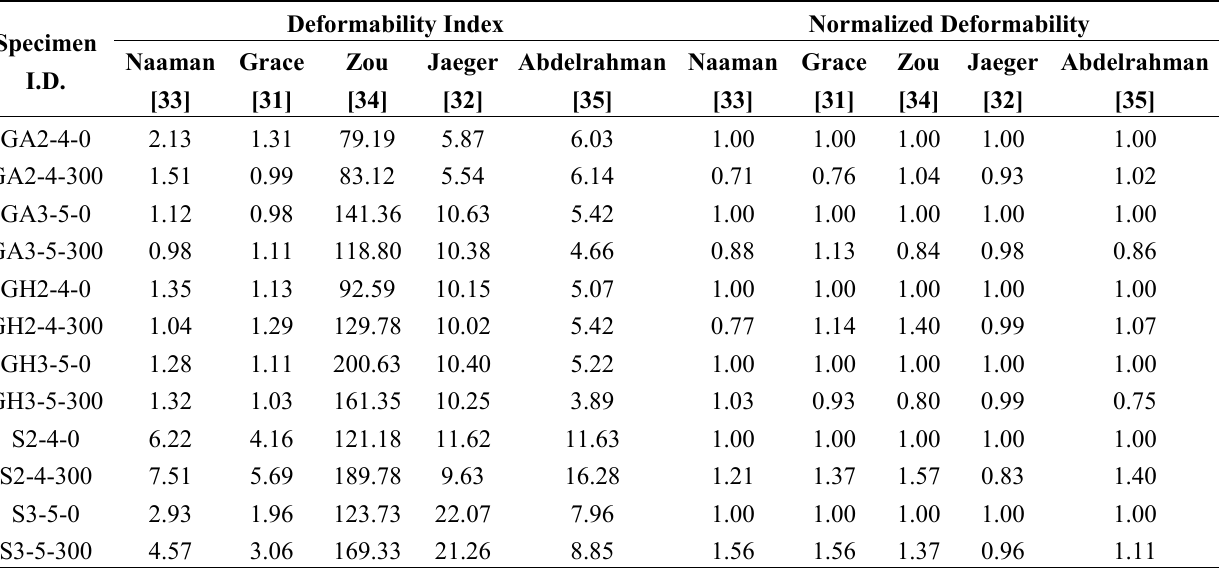
Table 7. Comparison of deformability indices and normalized